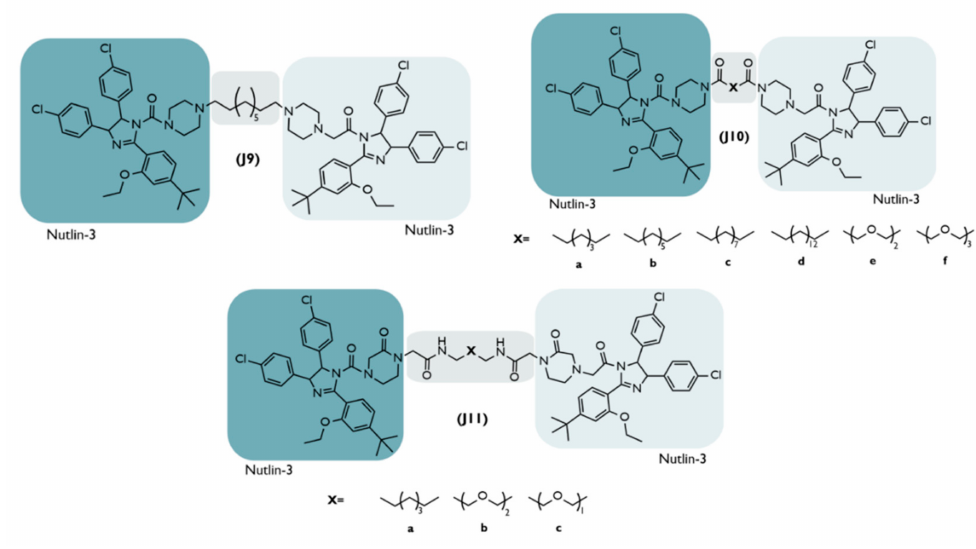
Figure 12. Chemical structure of HOMO-MDM2-based PROTACs. PROTACs J9, J10, and J11 have the same ligands at both ends, which allows them to recruit MDM2 and promote their own degradation [65]. When evaluated in four different tumor cell lines, the results allowed us to infer that the compounds with the highest affinity are the ones with the highest antitumor activity